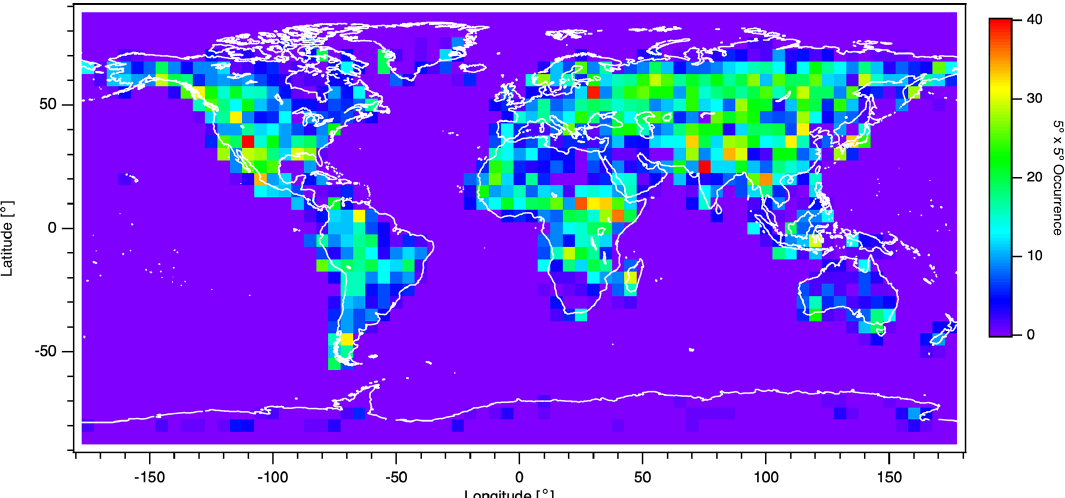
Figure 19. Benefit of the intelligent pointing mechanism: global map for occurrence of cloud cover index less than 1% after the intelligent pointing where before intelligent pointing cloud cover index was greater than 1% (September 2019, 5 ◦ × 5 ◦